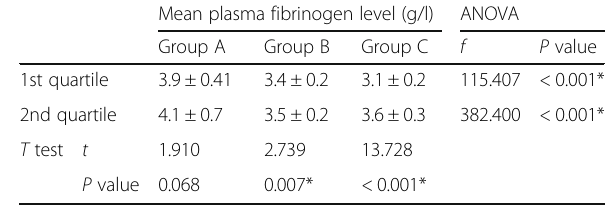
Table 4 Mean plasma fibrinogen level in stroke patients and control